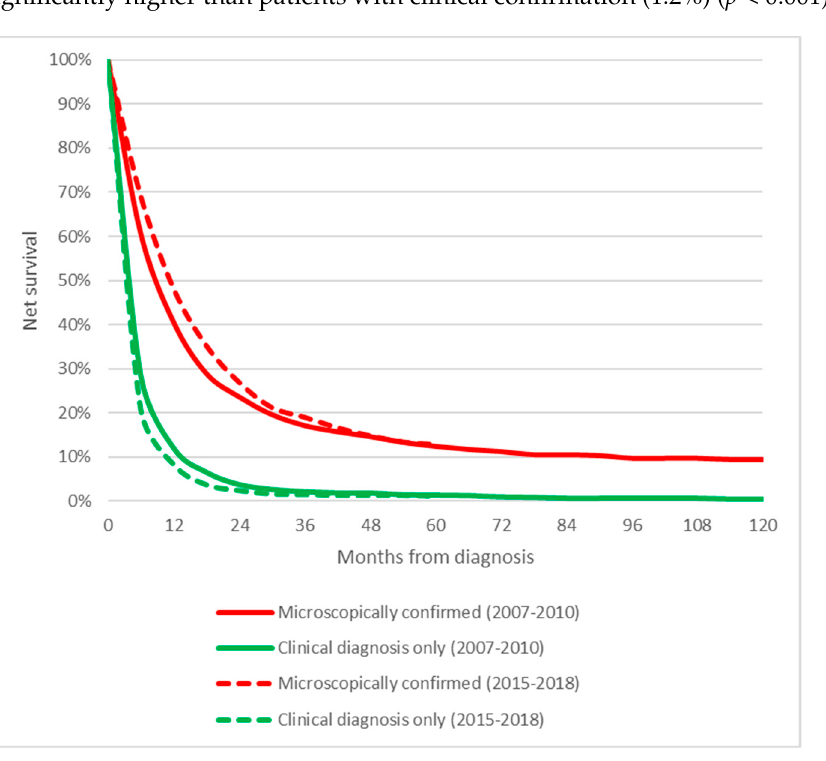
Figure 5. Survival of pancreatic cancer patients of the Veneto region population according to diagnostic confirmation and period.